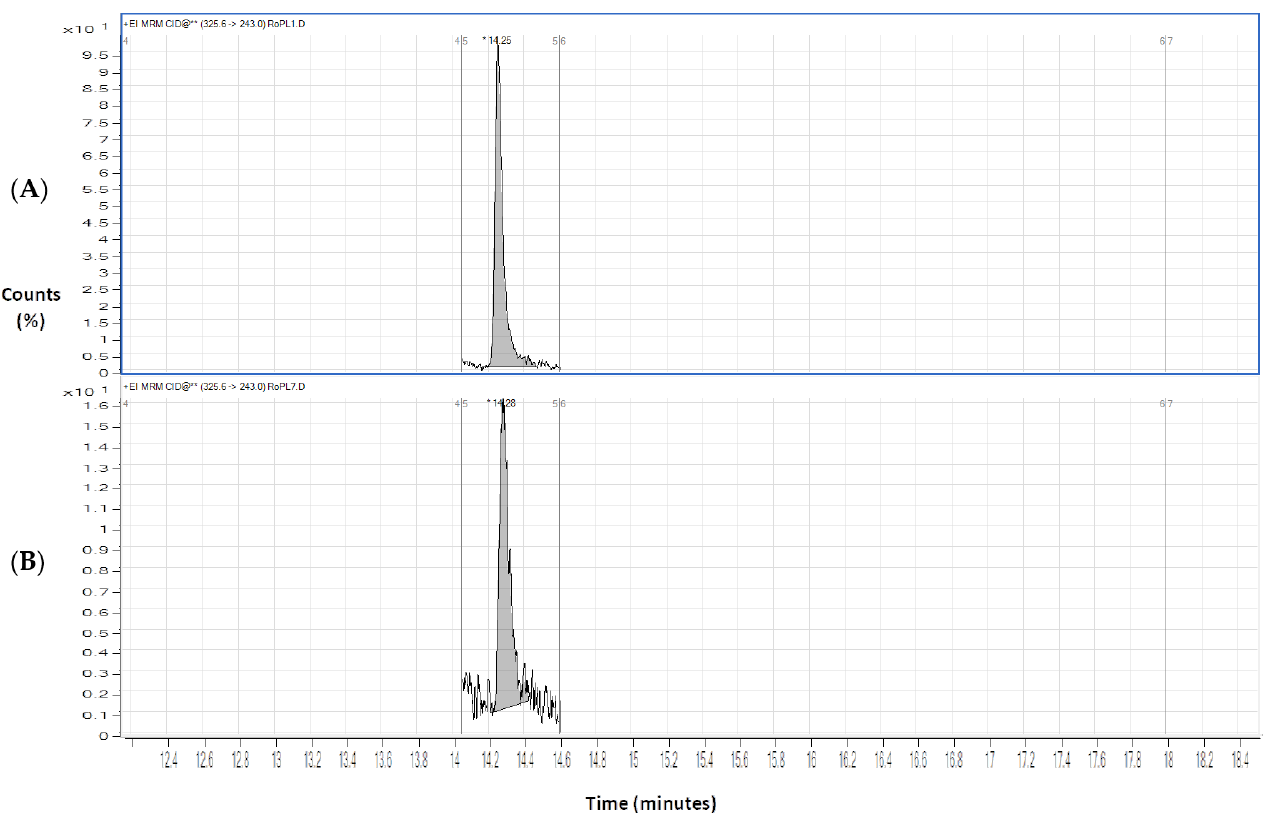
Figure 5. Chromatograms on the first ( A ) and seventh ( B ) days of extraction for clozapine (CLZ) (200 ng/mL) with sodium azide (0.1%).